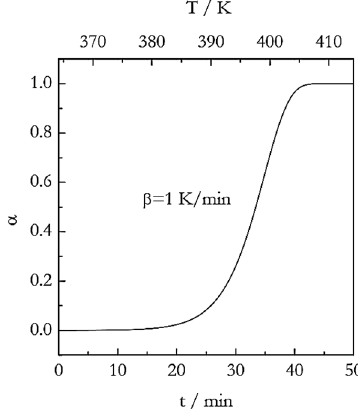
Figure 1. Simulated nonisothermal data for a process with the Avrami exponent, n = 3.